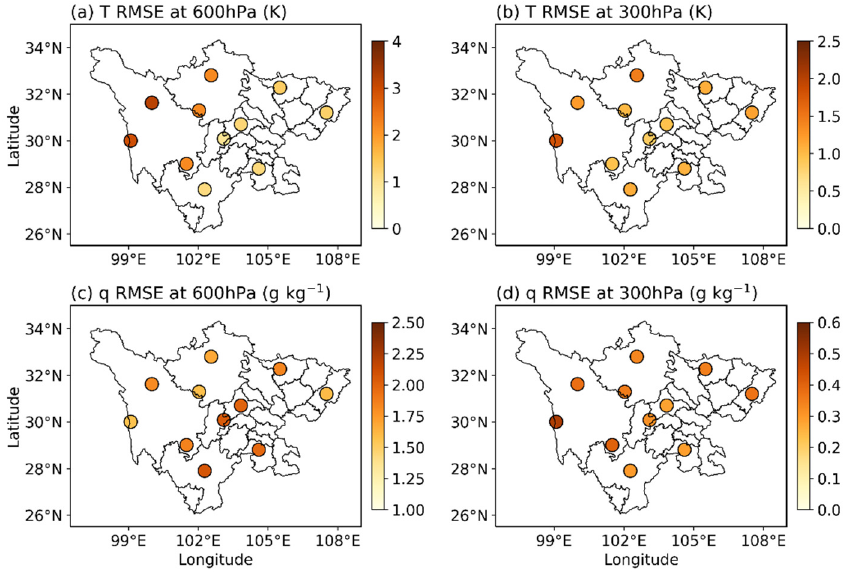
Figure 5. Same as in Figure 4, but for RMSE. ( a ) shows RMSE of T at 600 hPa, ( b ) at 300 hPa, and ( c ) RMSE of q at 600 hPa, ( d ) at 300hPa. RMSE of q at 600 hPa, ( d ) at